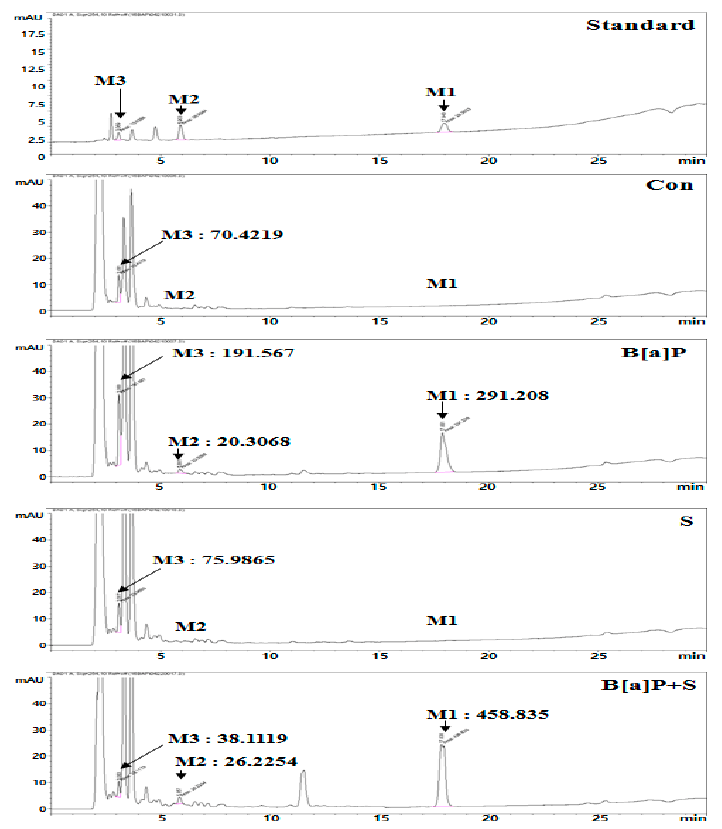
Figure 2. HepG2 cells were incubated with B[a]P (10 μ M) and co-treated with silymarin (40 μ M) for 48 h. The typical intracellular metabolites of B[a]P were measured by high performance liquid chromatography (HPLC). M1, B[a]P; M2, B[a]P-7,8-dihydrodiol; M3,